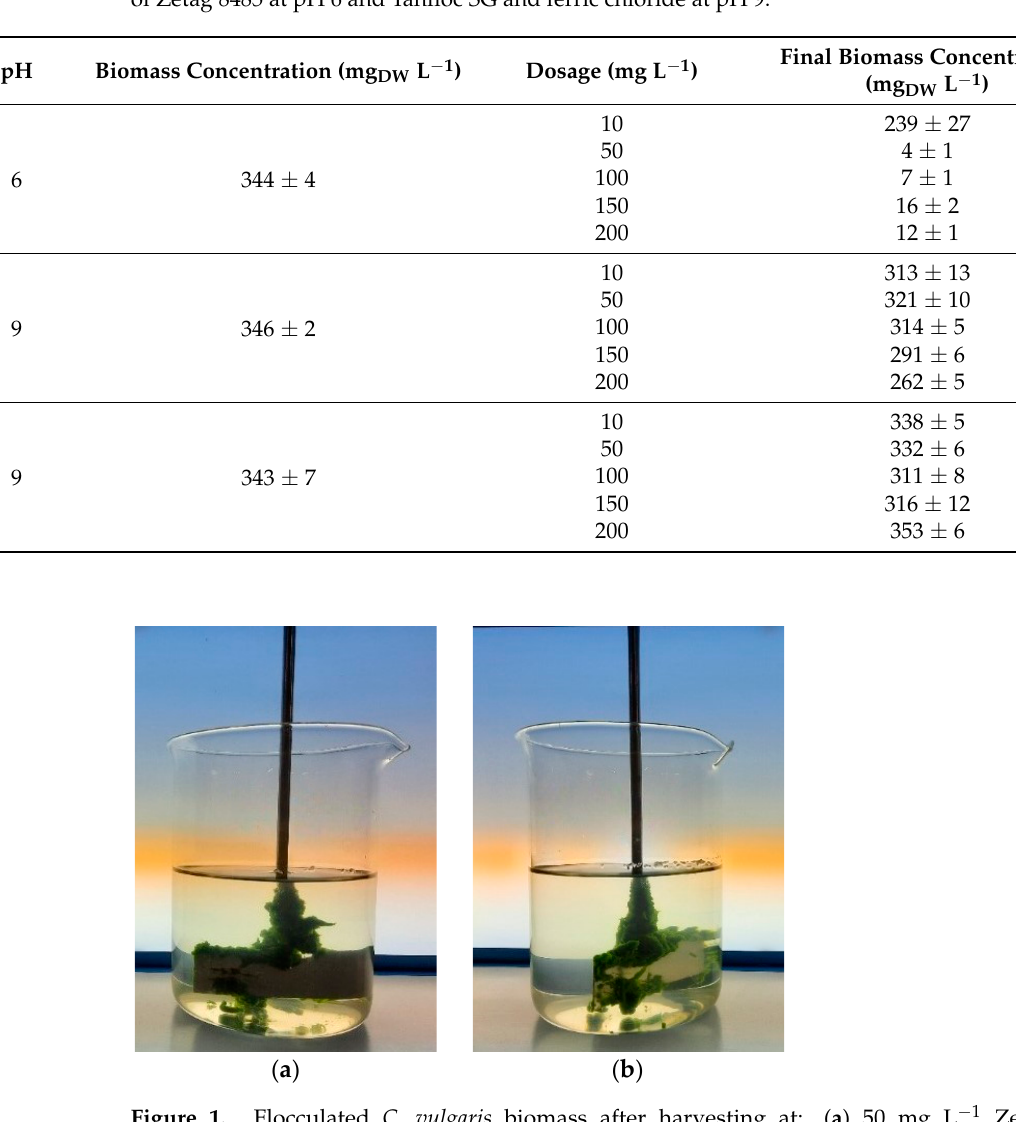
Table 3. Harvesting efficiency obtained in flocculation assays using concentrations of 10–200 mg L − 1 of Zetag 8485 at pH 6 and Tanfloc SG and ferric chloride at pH 9.